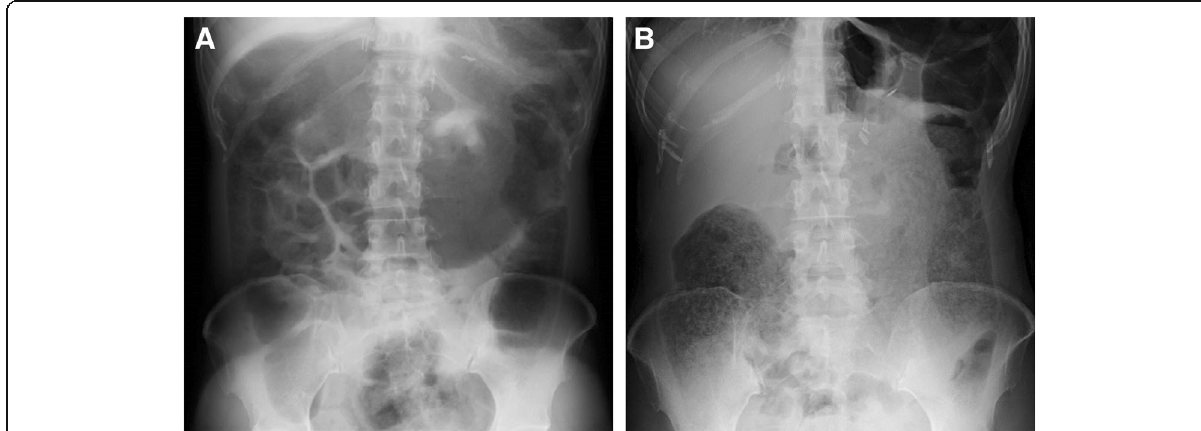
Fig. 2 Abdominal radiograph on admission ( a ) and on postoperative day 30 ( b ). Remarkable distended bowel and gas on admission was relieved on postoperative day